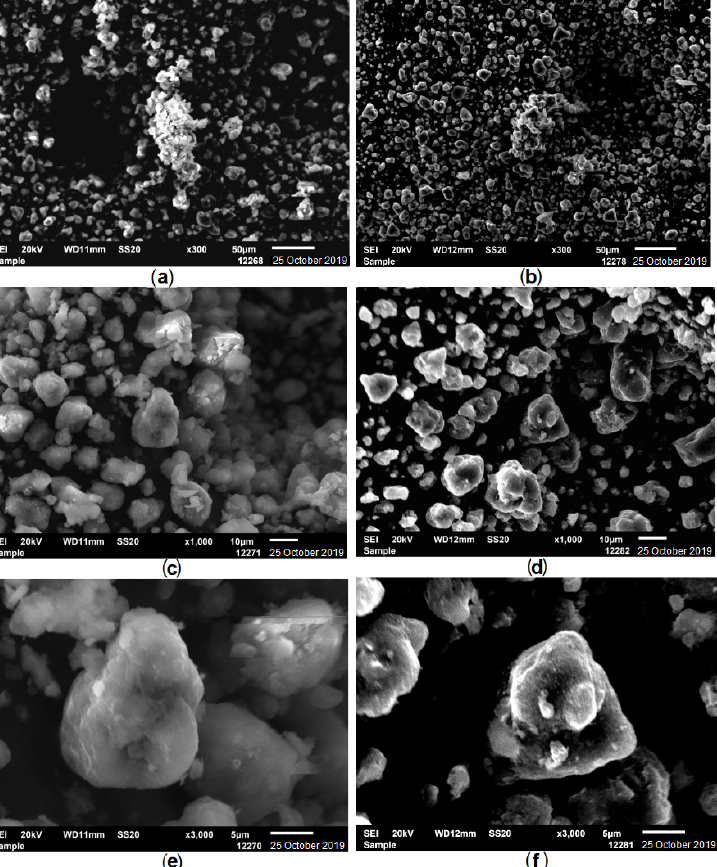
Figure 3. Micrographs of the 10% V/Al 2 O 3 system at different magnifications and heat treatment modes: ( a ) magnification by 300 times, 500 ° С ; ( b ) magnification by 300 times, 700 ° С ; ( c ) magnifica- tion by 1000 times, 500 ° С ; ( d ) magnification by 1000 times, 700 ° С ; ( e ) magnification by 3000 times, 500 ° С ; ( f ) magnification by 3000 times, 700 ° С .